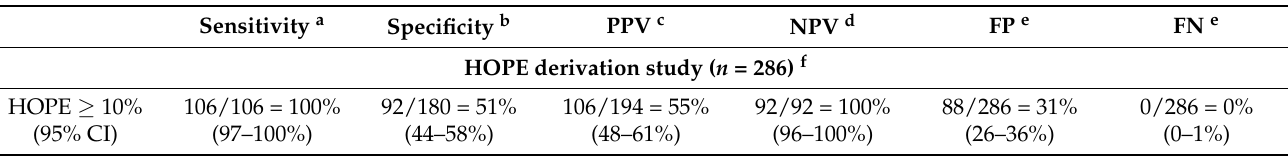
Table 2. Diagnostic performance when using HOPE survival probability ≥ 10% as criterion to decide to rewarm a patient (CI = confidence interval; HOPE = hypothermia outcome prediction after extracorporeal life